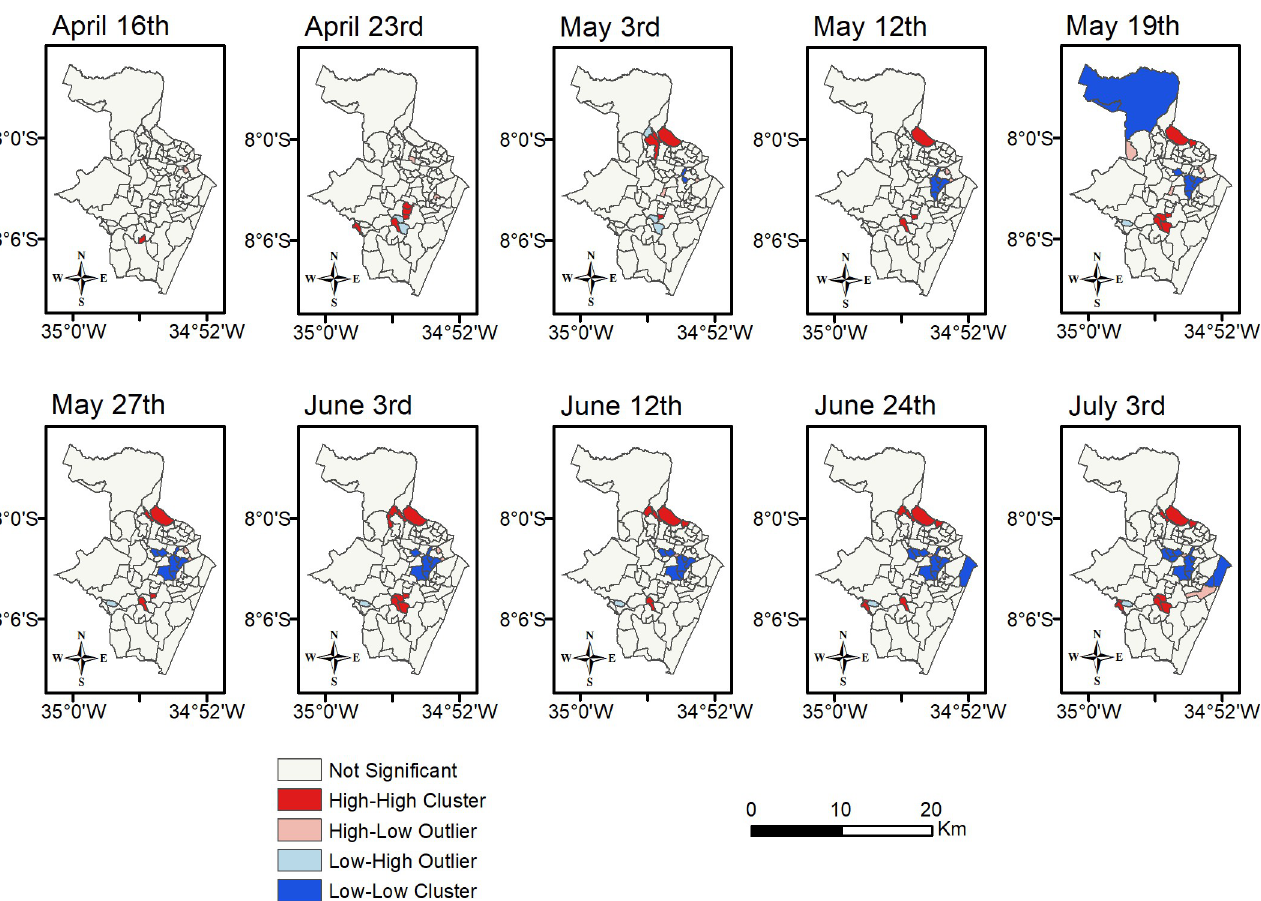
Fig 5. Spatial distribution of case-fatality in Recife as a result of cluster analysis.